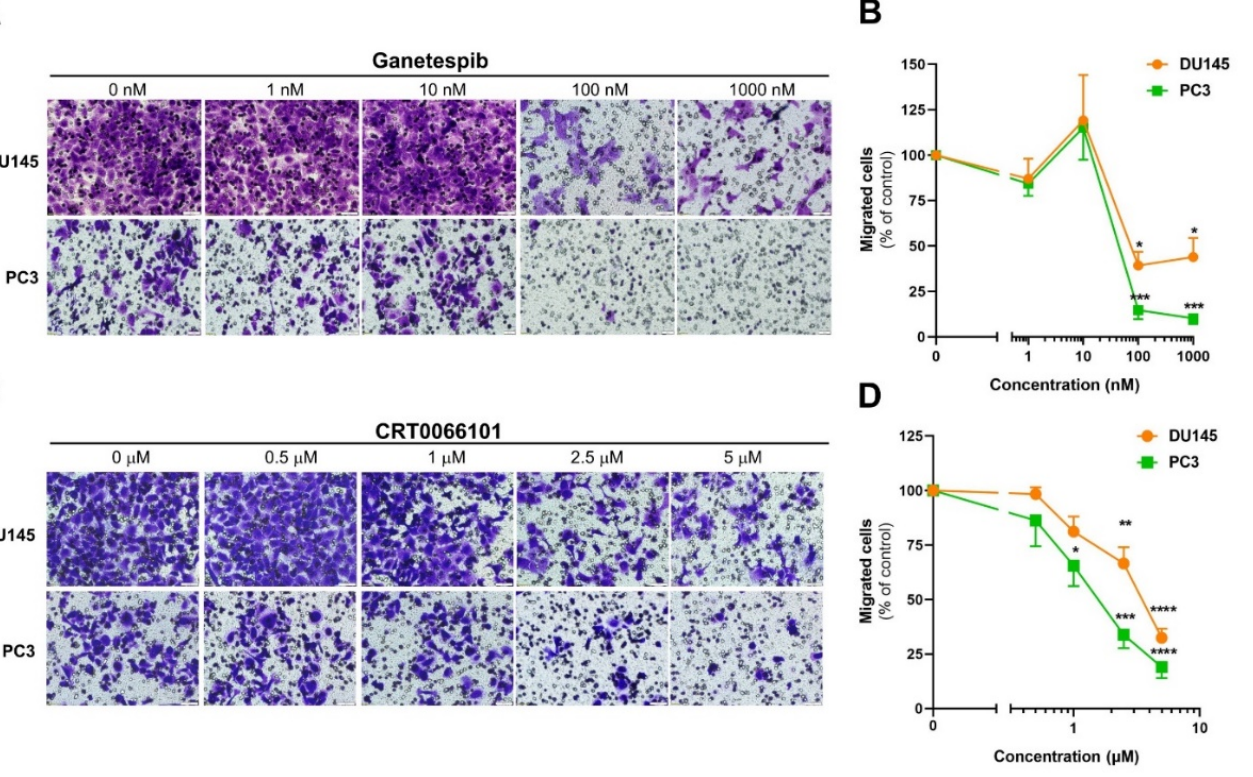
Figure 1. Inhibition of Hsp90 or PKD attenuates the migration of androgen-independent DU145 and PC3 prostate cancer cells. Cells were allowed to migrate for 22 h in the presence of the indicated doses of the inhibitors. Representative microscope images of ganetespib ( A ) and CRT0066101 ( C ) treatments, respectively. The scale bars represent 50 µm. Quantification of the results of ganetespib ( B ) and CRT0066101 treatment, respectively ( D ). All data are mean ± SEM values of 3 independent experiments. * p < 0.05, ** p < 0.01, *** p < 0.001, **** p < 0.0001 (two-way ANOVA with Tukey’s multiple comparison